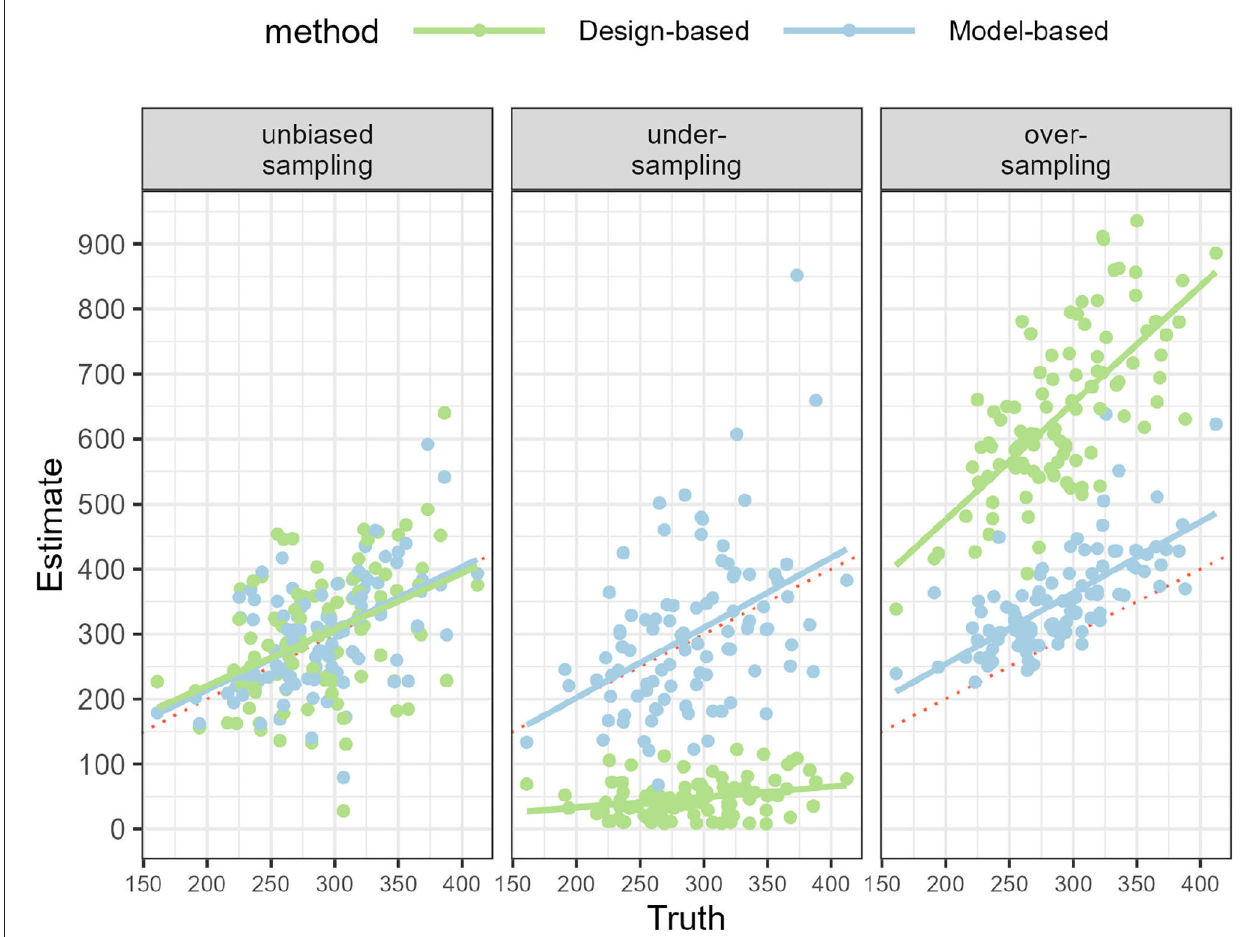
FIGURE 4 | Regression lines of point estimates against the true number of bycatch events, showing the calibration of the design- and model-based approach. The x -axis shows the true number of bycatch events across 100 simulations, spanning between 150 and 400 events. The red dotted line shows the identity line, i.e., no bias. Left: data sampling was unbiased and all methods yielded statistically unbiased estimates. Middle: Under-sampling scenario: only the model-based approach was well-calibrated. Right: Over-sampling scenario: both the design- and model-based approaches were not calibrated to the